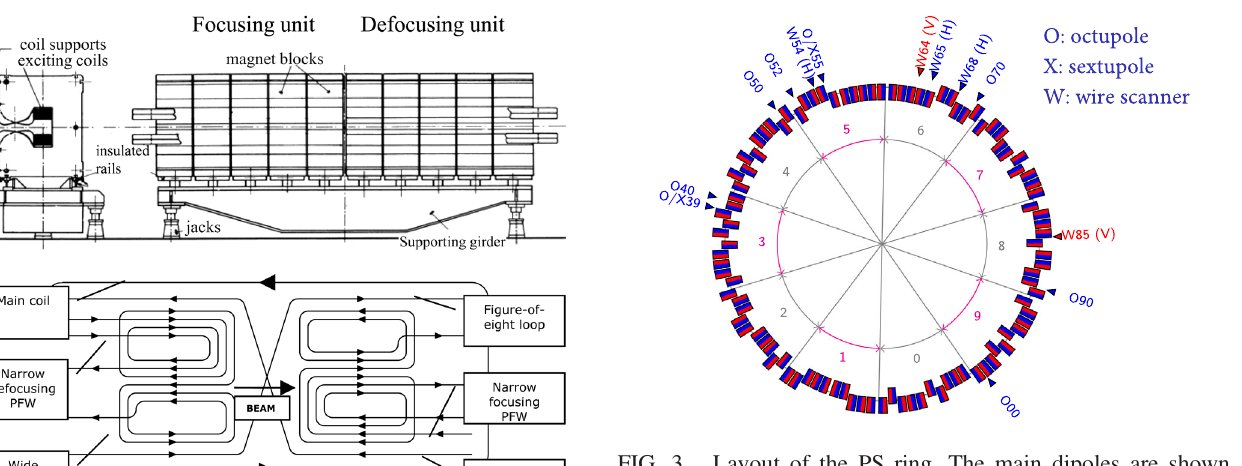
FIG. 3. Layout of the PS ring. The main dipoles are shown (blue and red shapes), including their focusing and defocusing half-units and the way they are installed, i.e., with the yoke inside or outside the circumference. The key elements to perform beam splitting are also shown, the number representing the name of the straight section in which they are installed, and the letter the magnetic type. The wire scanners are indicated together with the plane of